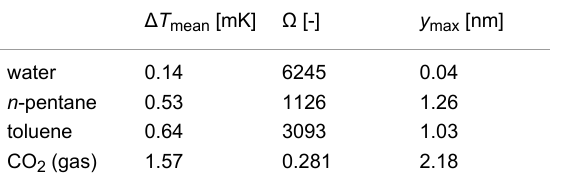
Table 2: Comparison of the mean temperature increase Δ T mean , the factor Ω , and the maximum deflection y max of the membrane in different liquids and CO 2 gas after 50 ms irradiation of 10 W/m 2 .